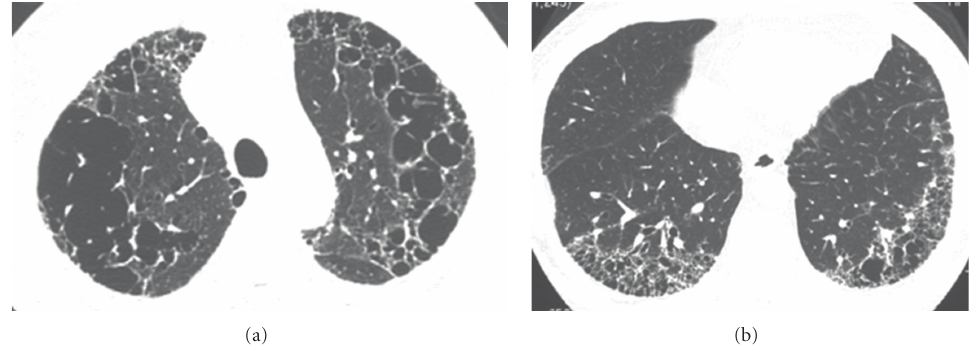
Figure 1: Imaging from a 64-year-old man with CPFE. (a) HRCT of bilateral upper lung fields shows emphysema. (b) HRCT of bilateral lower lung fields shows traction bronchiectasis and honeycomb and reticular opacities.